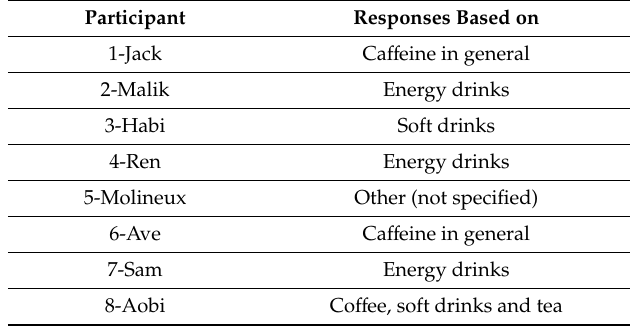
Table 3. Beverage chosen during ca ff eine expectancies questionnaire (Ca ff EQ)